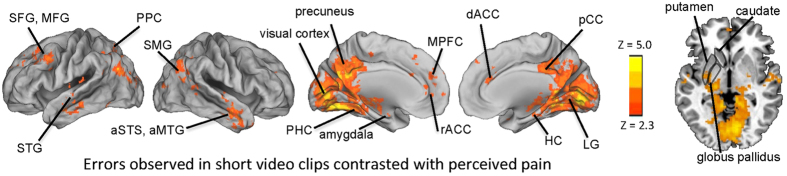
Brain regions showing significantly stronger activity during observed errors than during perceived pain in videoclips in Experiment 1.The areas significantly activated in this control analysis are plotted with yellow-red color. All statistical parameteric maps were thresholded Z > 2.3 and cluster-wise corrected at P < 0.05.